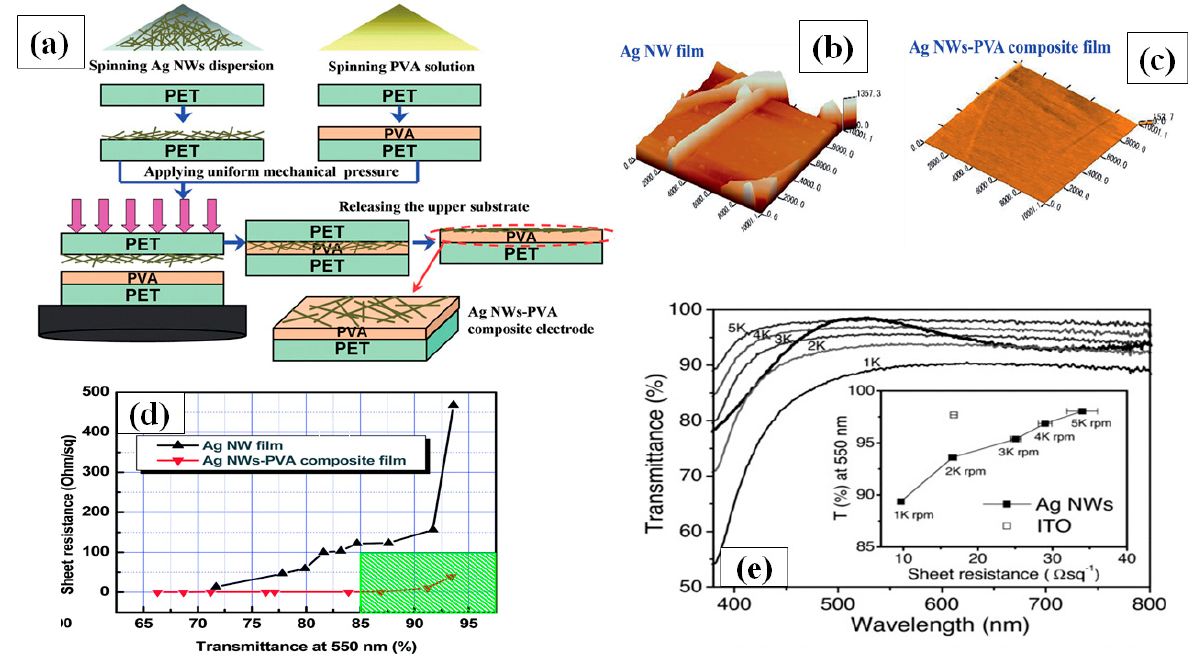
Figure 9. ( a ) A schematic procedure for AgNW/ PVA thin film fabrication by spin coating, ( b – c ) surface morphology of ( b ) bare AgNW and ( c ) AgNW/PVA composite film on PET ( d ) Transmission-resistance graph for AgNW and AgNW/PVA composite electrodes (adapted from [156] with permission from Royal Society of Chemistry, 2014) ( e ) a transmittance vs. resistance graph for different spin coating speed (1000–5000 rpm) (adapted from [153] with permission from John and Wiley sons, 2011).